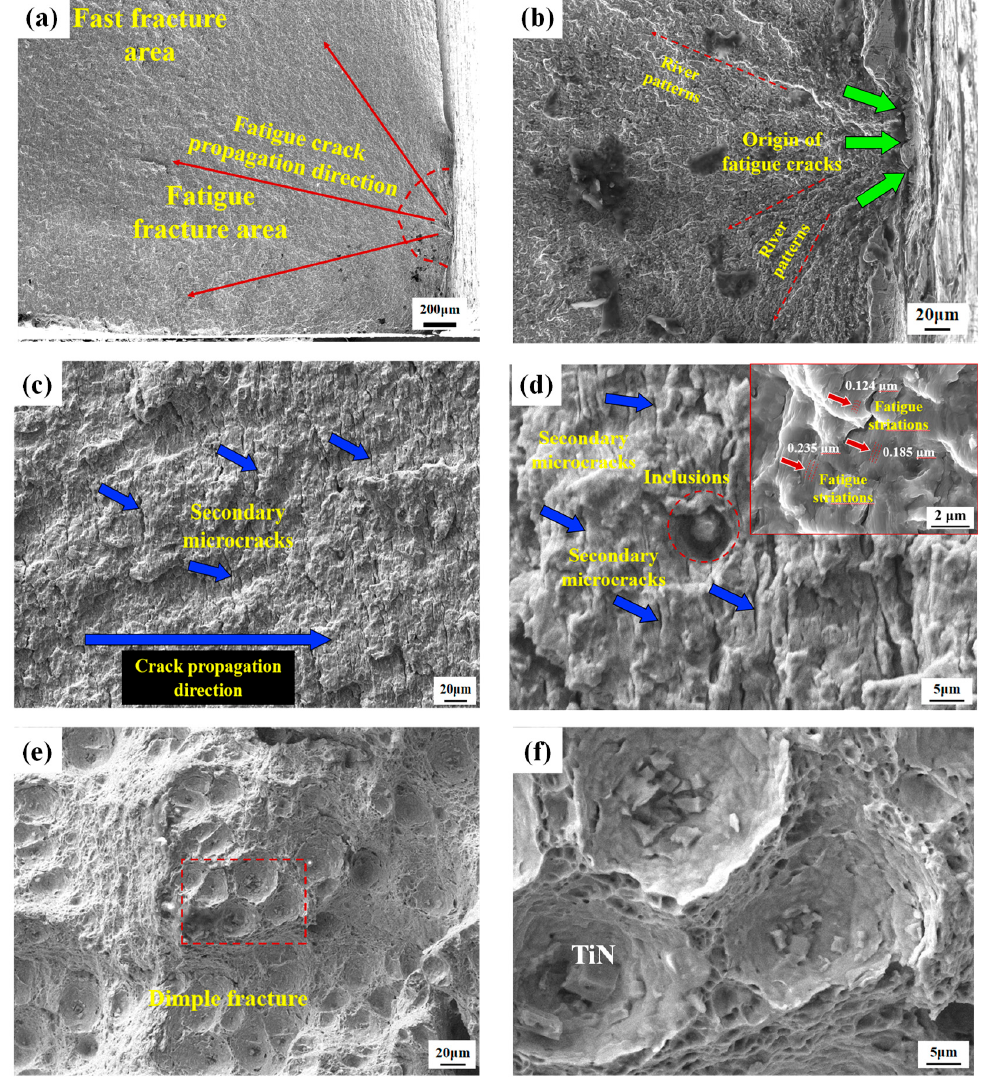
Figure 9. Fatigue fracture morphology of Beam-1 Steel, σ a = 630 MPa, N f = 6.28 × 10 5 : ( a , b ) fatigue crack initiation area, ( c , d ) fatigue crack stable propagation area, ( e , f ) fatigue crack instability propagation area.